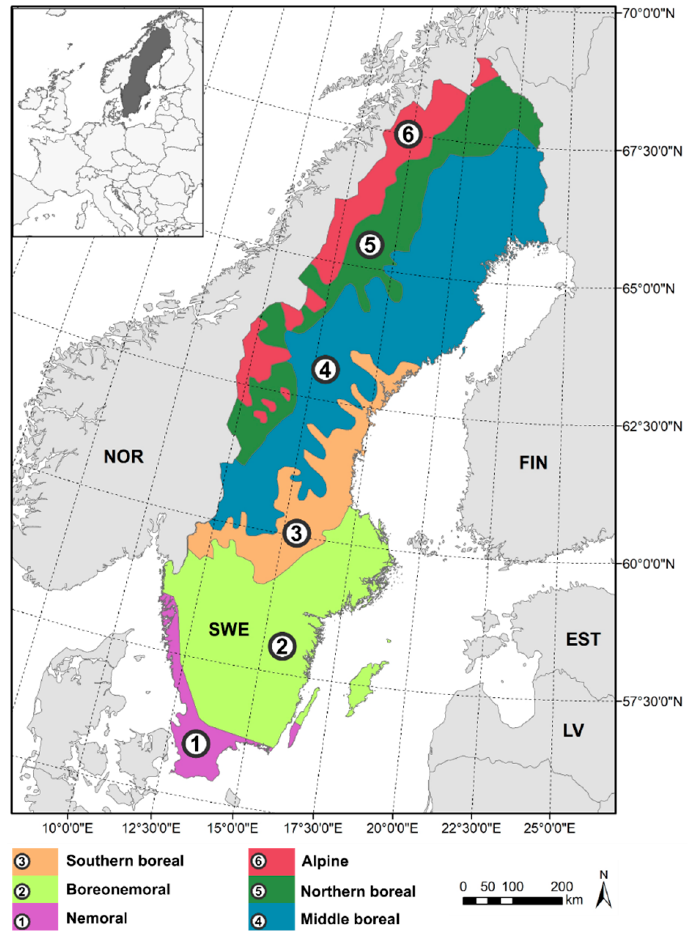
Figure 1. Study area (Sweden) and vegetation zones used for modeling.